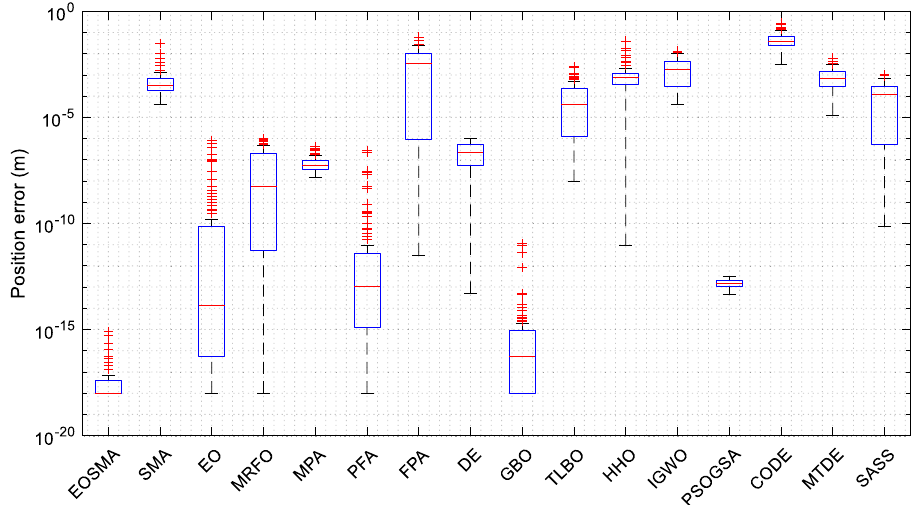
Figure 10. Box plot of optimization results of randomly selected position points.